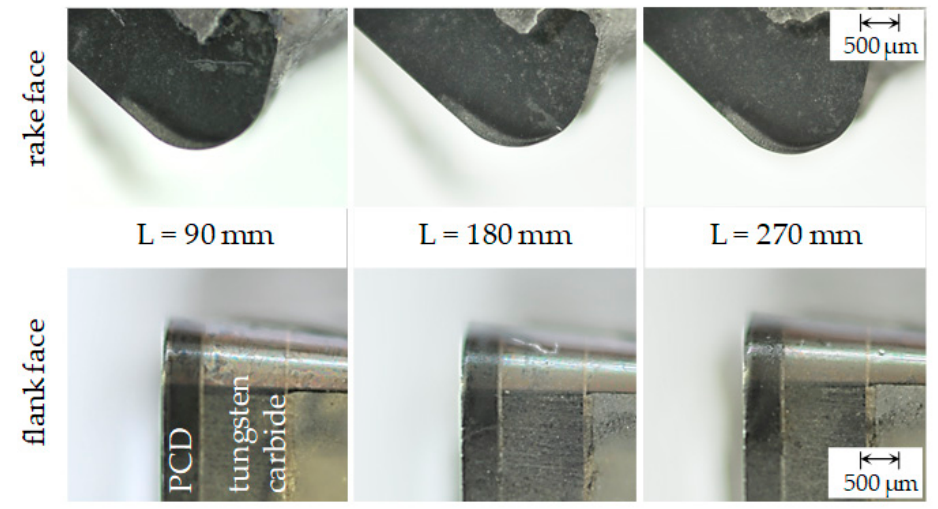
Figure 5. Results of wear pattern at the PCD cutting insert’s rake ( top ) and flank face ( bottom ) after each 90 mm machining length.